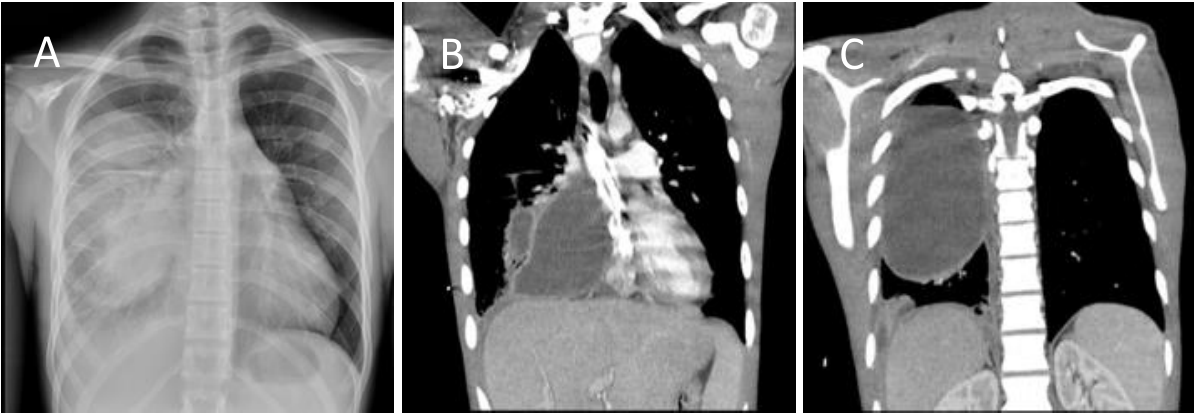
Figure 1. A: Right lung with significant density, without pneumothorax, B: loculated fluid collection anteriorly in right lung, left mediastinal shift, C: loculated fluid collection noted posteriorly in right lung.